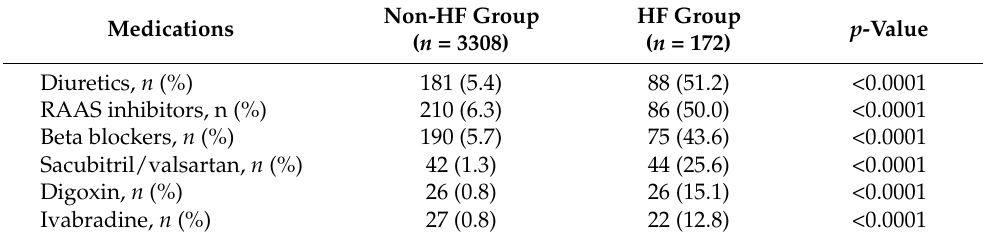
Table 7. Comparison of medications between the HF and non-HF groups.